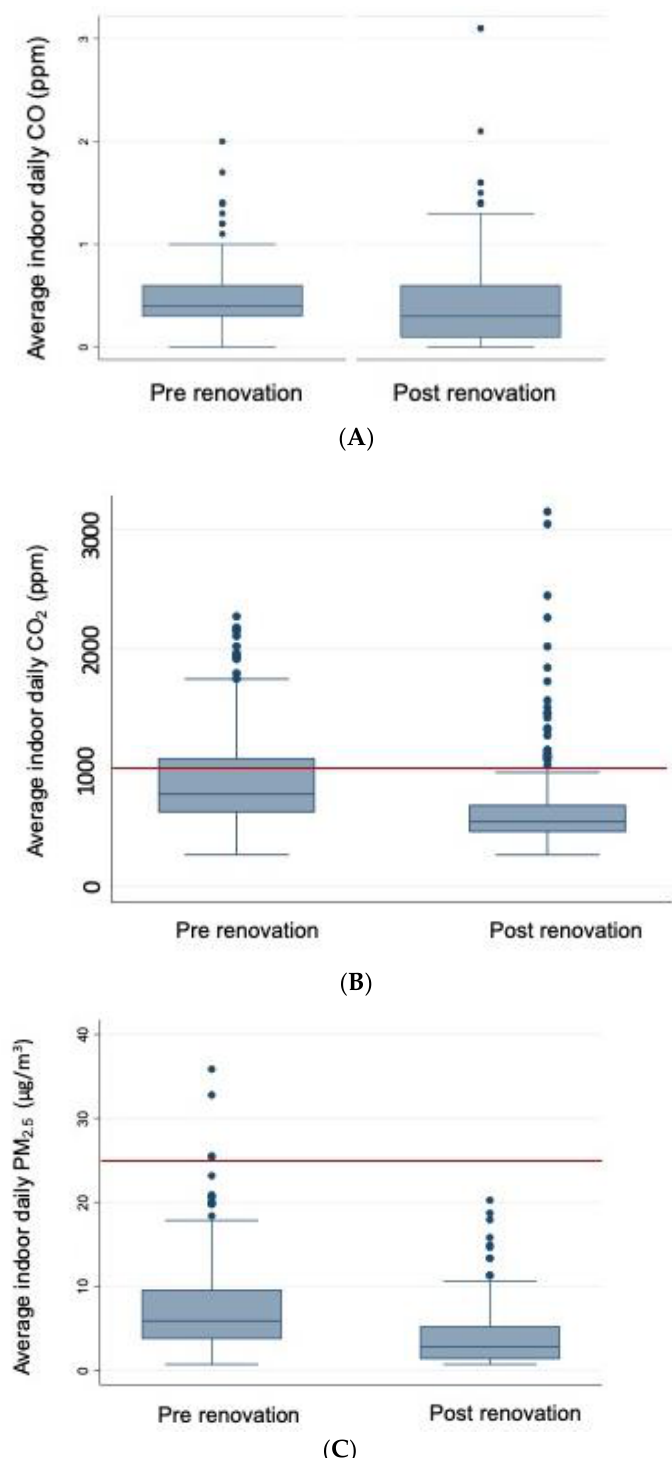
Figure 1. Indoor air quality measures by school renovation status in seven schools with pre- and post-